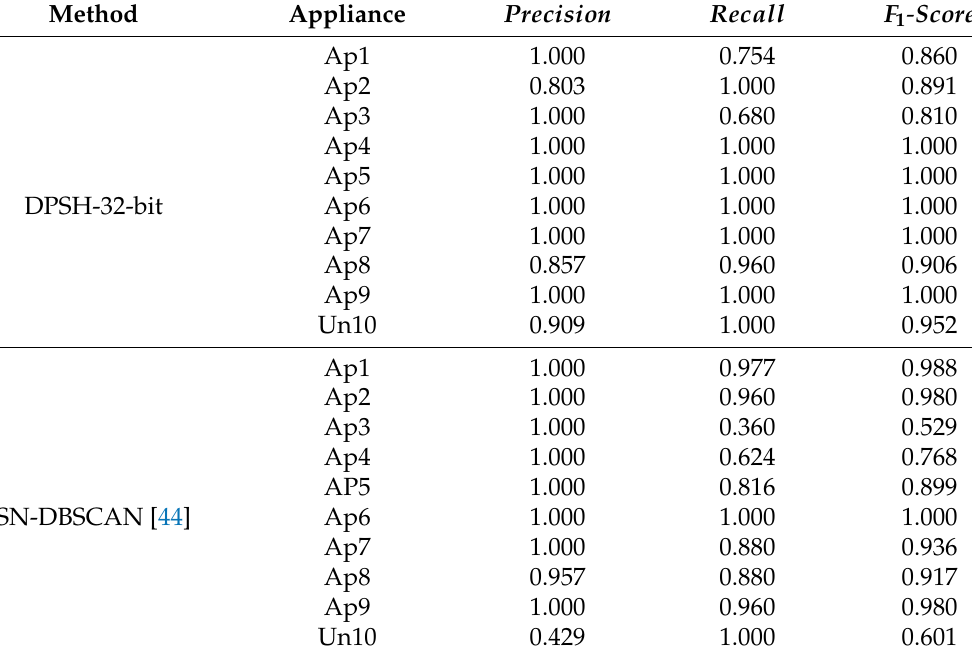
Table 5. The disaggregation performance on REDD with unidentified appliance.